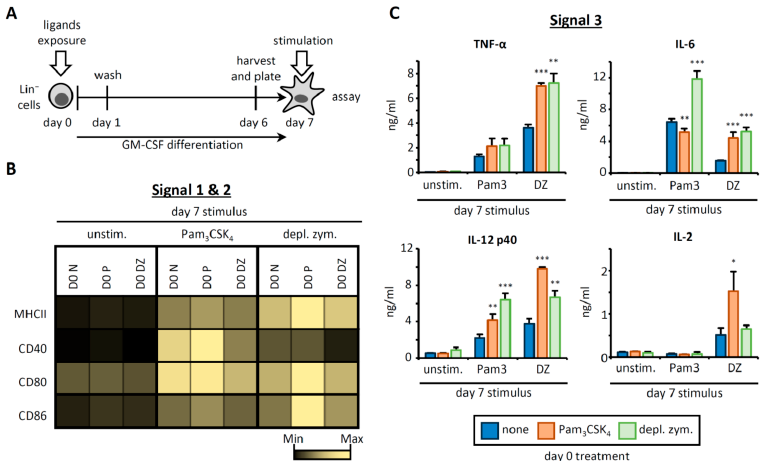
Figure 1. Pam 3 CSK 4 - or depleted zymosan-stimulated hematopoietic stem and progenitor